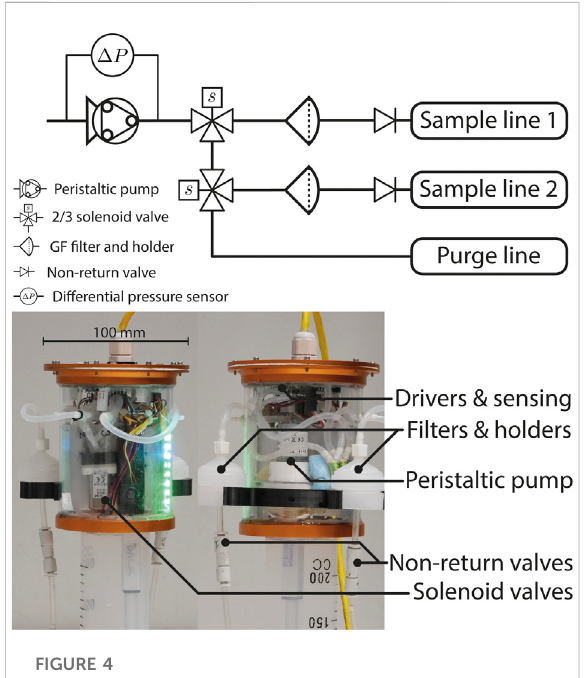
FIGURE 4 Filter based sampling system integrated in the μ UV : hydraulic diagram (top), and physical components